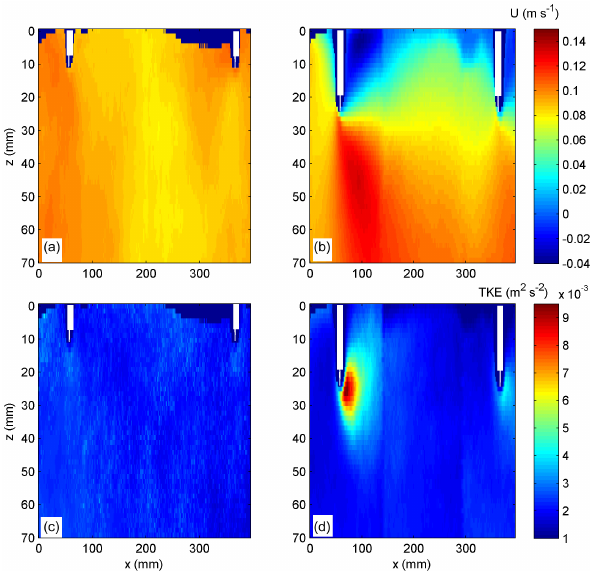
Figure 3. Laboratory measurements of the mean longitudinal flow velocities ( U ) (a) below a drifting chamber and (b) below an an- chored chamber. Mean turbulent kinetic energy (TKE) of the flow fields below (c) the drifting chamber and (d) the anchored chamber. z and x refer to depth and longitudinal distance respectively. Cham- ber edges are blocked out (white) and regions without sufficient ob- servations for temporal averaging are marked by a dark blue color. The flow direction is from left to right and the mean flow velocity was 0.1ms − 1